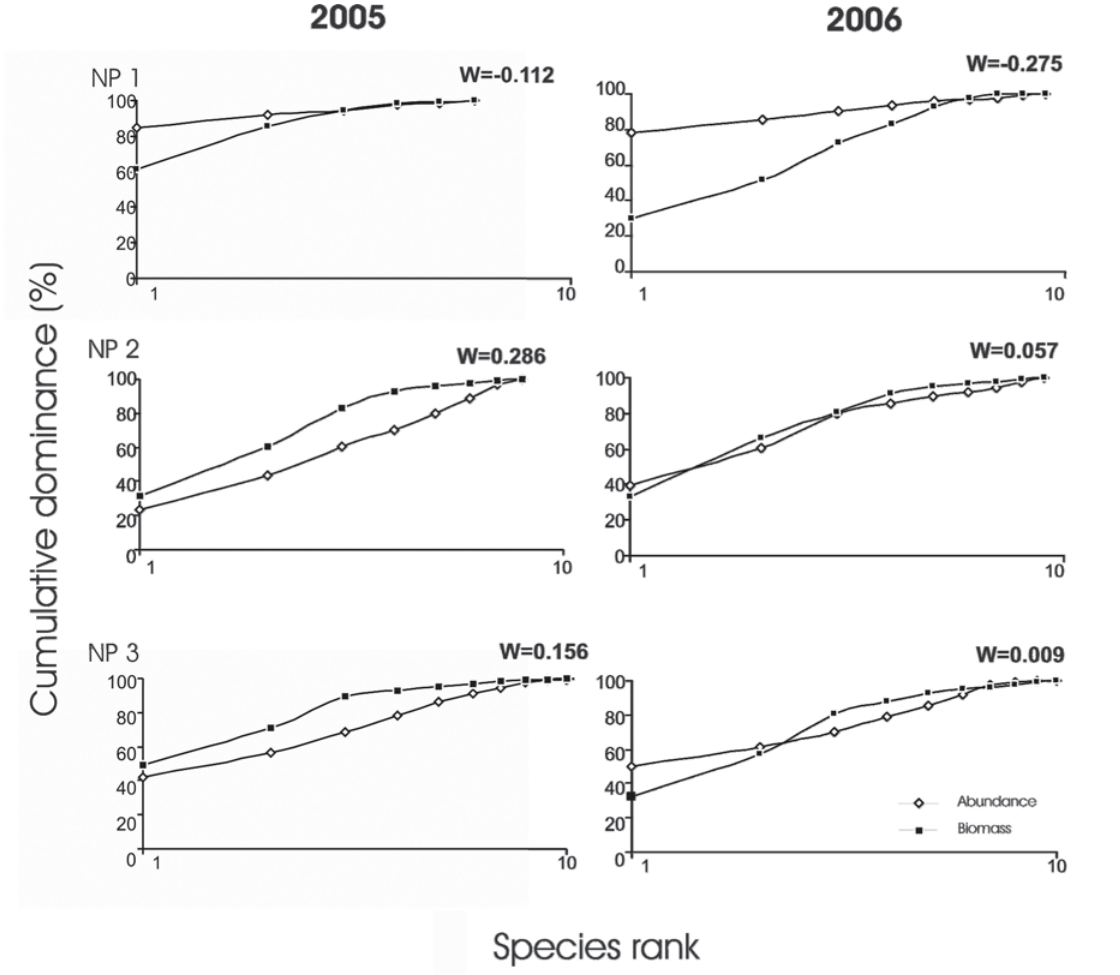
Fig. 5. ABC curves per year of fish assemblages from stream stretches located in impacted areas. NP1 = Palmito; NP2 = Onça; NP3 = Unnamed Stream 3. W = statistical value for each